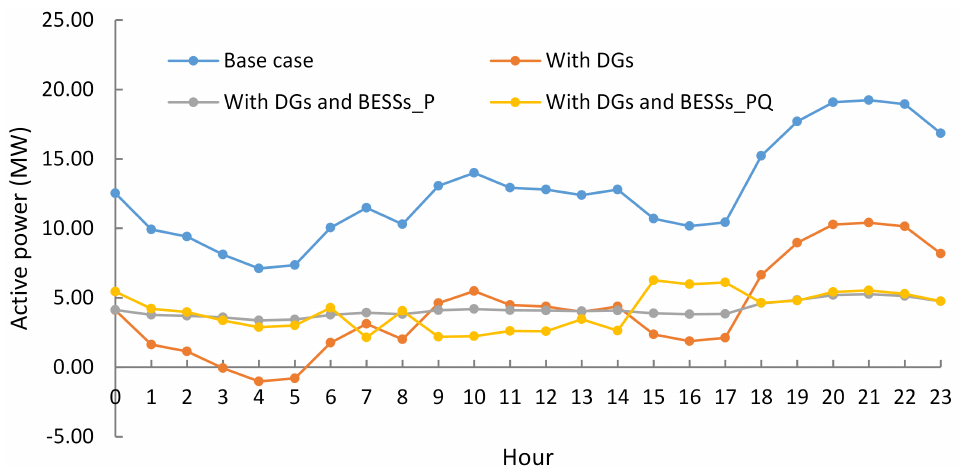
Figure 14. Slack bus generation of the 141-bus test